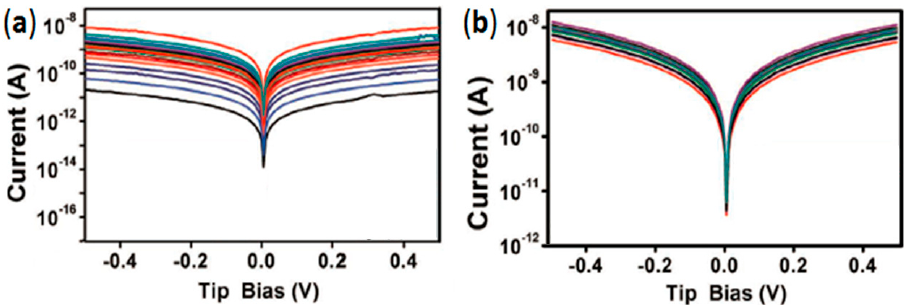
Figure 12. Variability and stability test. ( a ) Average I-V data for Au/octanemonothiol/Au junctions with 18 different Au tips; ( b ) Average I-V data for Au/octanemonothiol/graphene/Au junctions with 18 different graphene tips. Reproduced with permission from [23], copyright Wiley-VCH (2012).